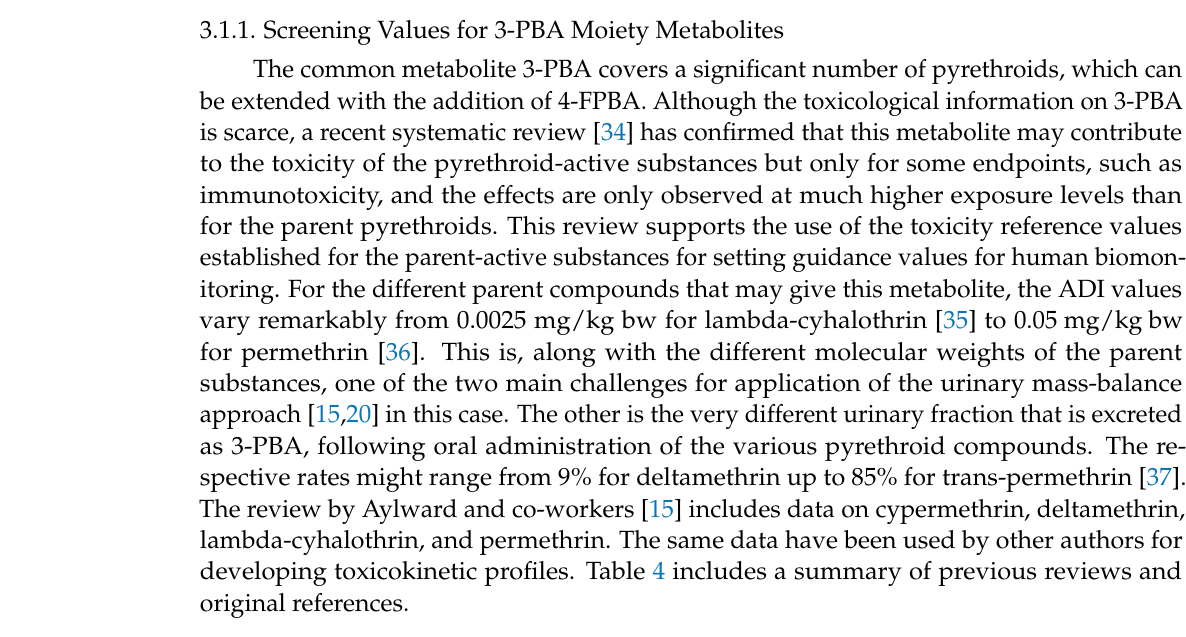
Table 4. Extraction of data on molar 3-PBA urinary excretion rates (moles of 3-PBA in urine per mole of orally administered parent